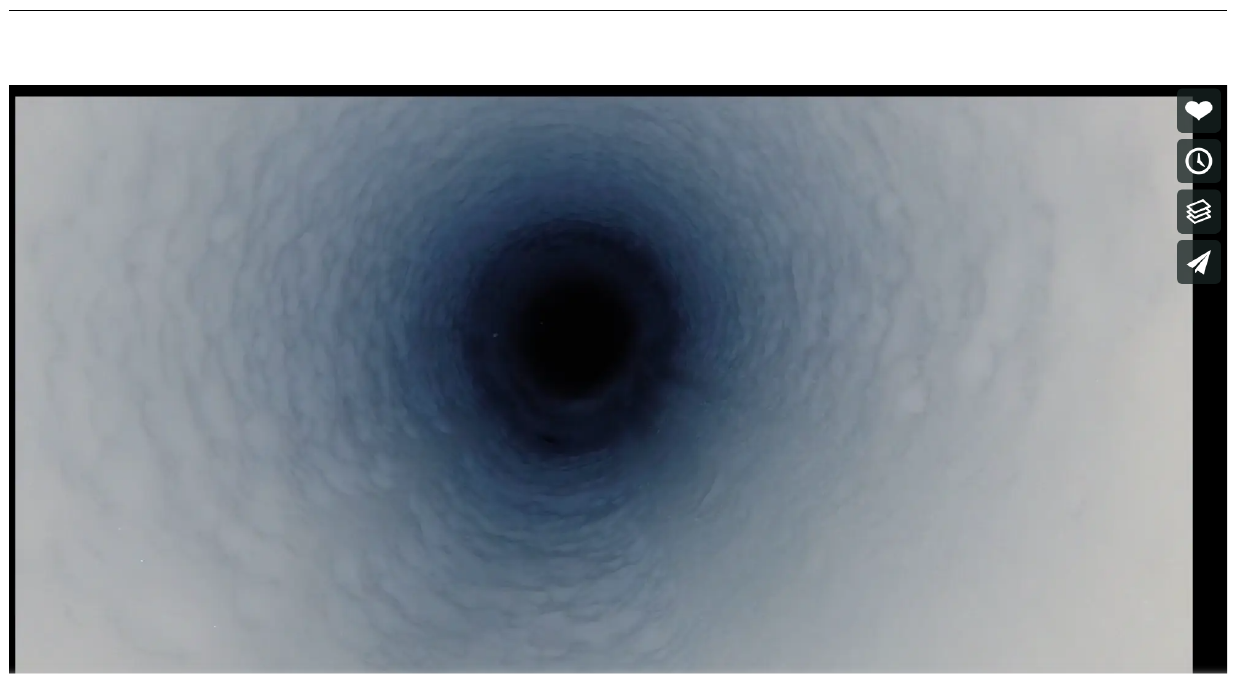
Figure 8: Kasic in Antarctica, on top of Subglacial Lake Mercer, 2019. Courtesy of Kathy Kastic and the SALSA Science Team.